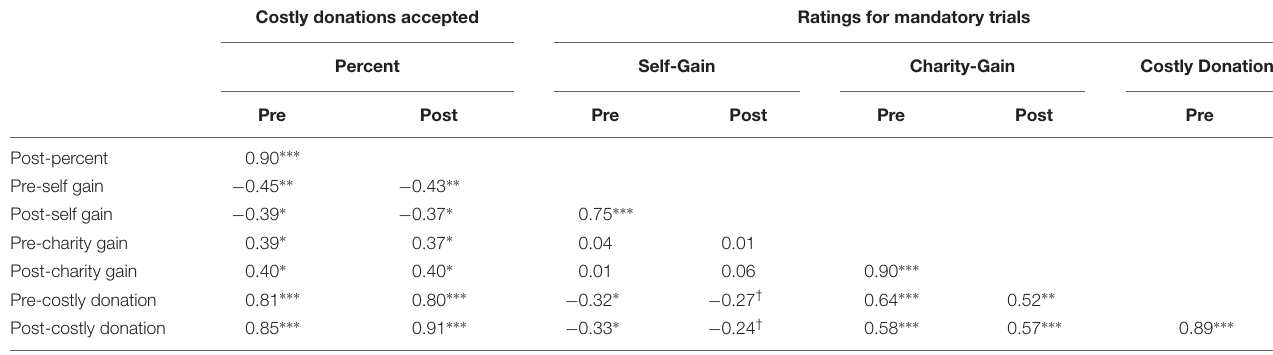
TABLE 6 | Pearson’s R values for pairwise correlations between pre- and post-test behavioral measures.